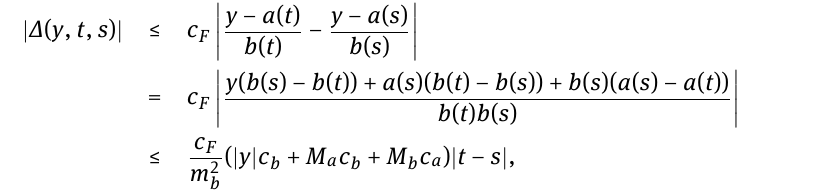
Figure 3: Student distribution with ν = 4 df. (a): Simulated data ( + ) and conditional quantiles q (3/4 | ·) (magenta), q (1/2 | ·) (green) and q (1/4 | ·) (blue). (b): Location function a (·) (black) and mean estimate ¯ˆ a ¯ˆ mean estimate b n (·) (red). (d): Conditional tail-index γ (black), estimates ˆ γ n , i , i = 1, . . . , N (blue) and mean estimate ¯ˆ γ n (red) as functions of k 1, . . . , 300 } n ∈ {